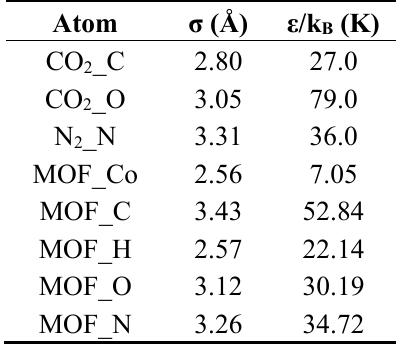
Table 2. LJ potential parameters for CO 2 , N 2 , and bio-MOF-11 studied in this work.